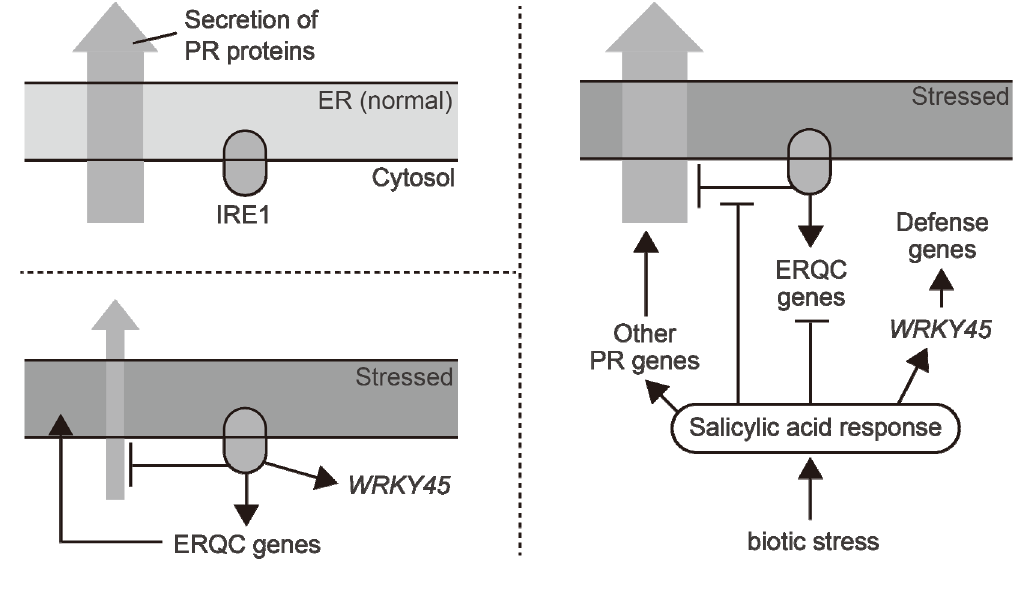
Figure 4. Model of the relationship between IRE1-mediated unfolded protein response (UPR) and the defense system in rice. Under normal conditions, certain types of PR proteins are secreted through the ER and maintain basic disease resistance (upper left panel). When ER stress conditions arise, to relieve this stress, IRE1-mediated UPR pathways induce ERQC-related factors and reduce the gene expression of PR proteins (lower left panel). Additionally, the IRE1-mediated pathway induces the gene expression of OsWRKY45, which improves disease resistance. When the salicylic acid (SA) response is activated concomitantly with UPR, most of the aforementioned effects of IRE1-mediated UPR are suppressed (right panel). The SA response induces other types of PR genes and the OsWRKY45 gene in an IRE1-independent manner and activates the accumulated OsWRKY45 to further improve disease